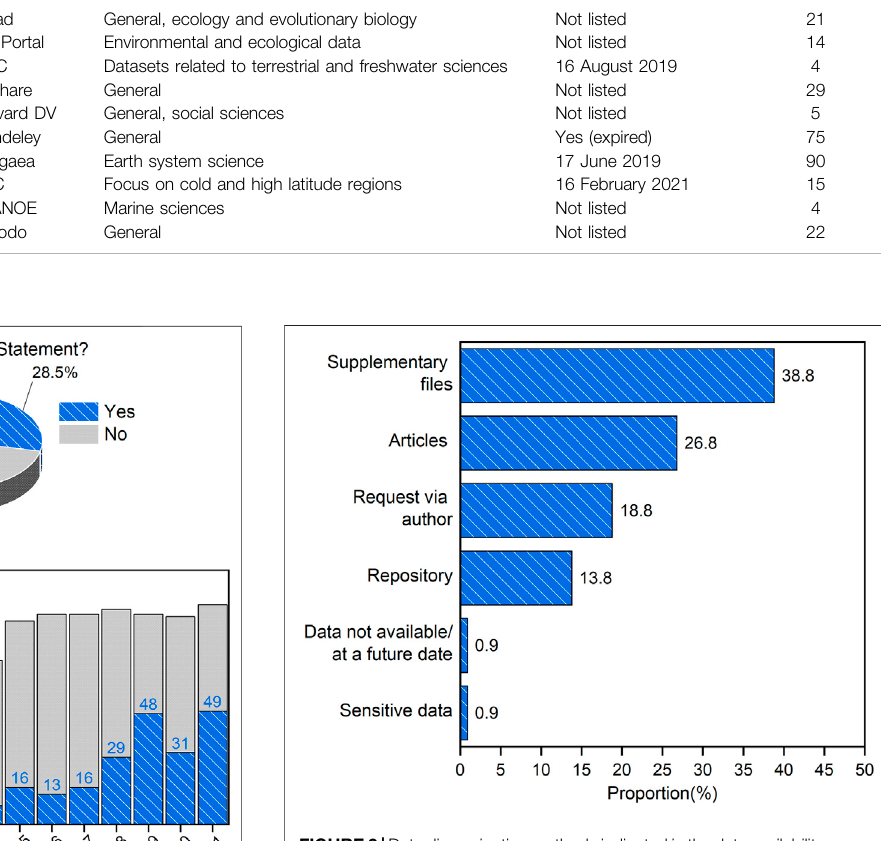
FIGURE2| Datadisseminationmethodsindicatedinthedataavailability statements of the articles analysed in this study.